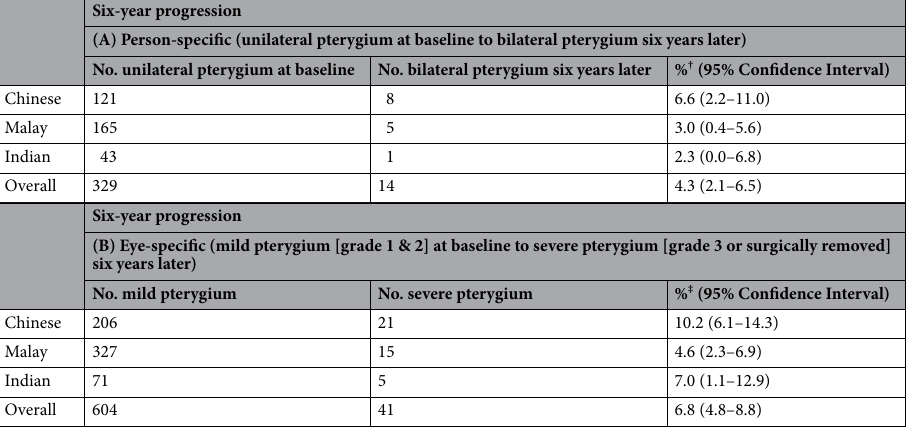
Table 3. Progression of Pterygium across the ethnic groups of Chinese, Malays, and Indians. (A)†Percentage of subjects who progressed from unilateral at baseline to bilateral pterygium six-year later. ‡ P values for progression rate comparisons between ethnic groups: Chinese vs. Malay, P = 0.164; Chinese vs. Indians, P = 0.448; Malay Vs Indian, P = 1.000. (B)‡ percentage of eyes with progressed from grade 1 or 2 pterygium at baseline to grade 3 or surgically removed pterygium six-year later. ‡ P values for progression rate comparisons between ethnic groups: Chinese vs. Malay, P = 0.019; Chinese vs. Indian, P = 0.637; Malay Vs Indian, P = 0.374.